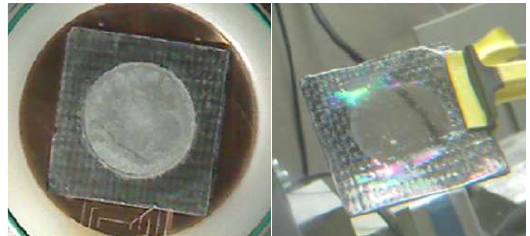
Fig. 3. 7 Be targets (PSI): electrodeposited target (left), evaporated target by micro-drop deposition